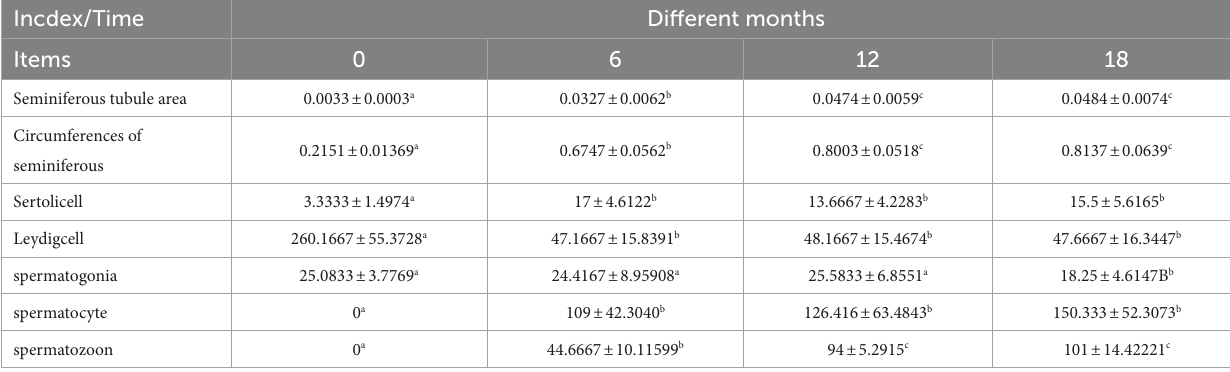
TABLE 2 Histomorphological and physicochemical indices of the testis. Incdex/Time Different months